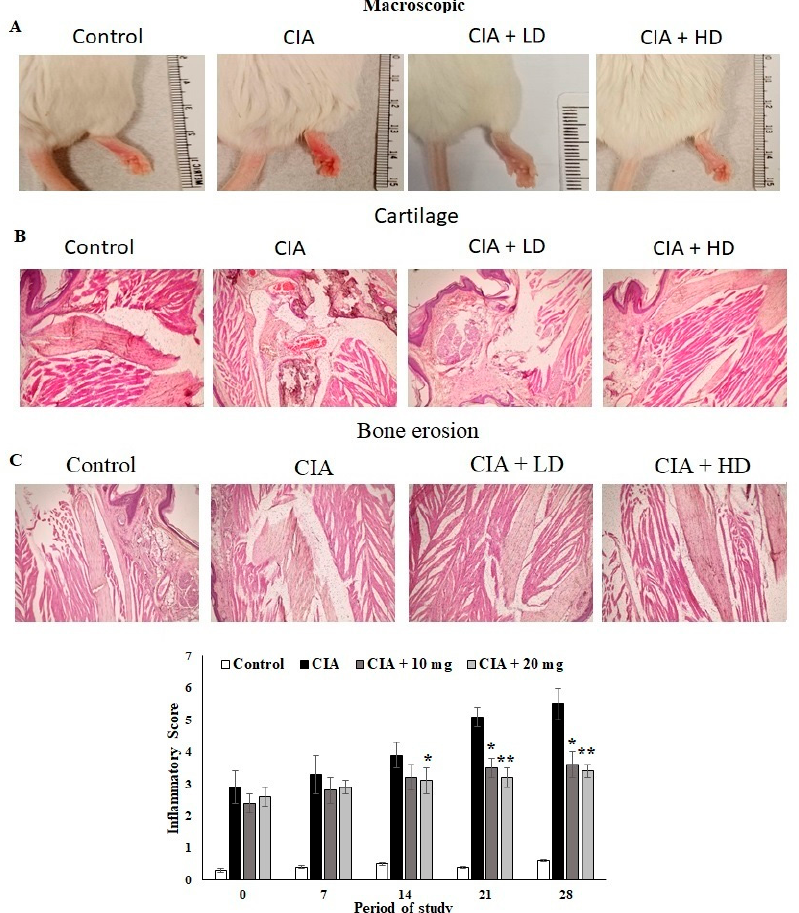
Figure 3. Macroscopic and microscopic examinations of CIA mice treated with EAE extracts. ( A ) Macroscopic observations on the day before the mice were sacrificed on day 27. ( B , C ) Histopatho- logical alterations of collagen-induced arthritis in mice. Section of hind limbs of control mice showing normal characteristics. Arthritis mice showing alterations (infiltration of inflammatory cells, INF, destruction of cartilage, CA, bone erosion, BE). PCB-treated CIA mice showing lower number of infiltrated inflammatory cells and cartilaginous cells. Muscle cells with normal appearance were observed. All the values are expressed as mean ± SEM; each group contained 6 mice; * p < 0.05 and ** p < 0.001 in EAE-extract-treated CIA mice compared to disease mice (CIA alone) ( n =